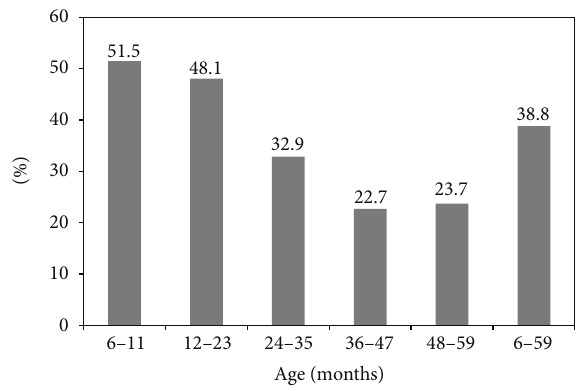
Figure 1: Prevalence of anemia among children by age group.